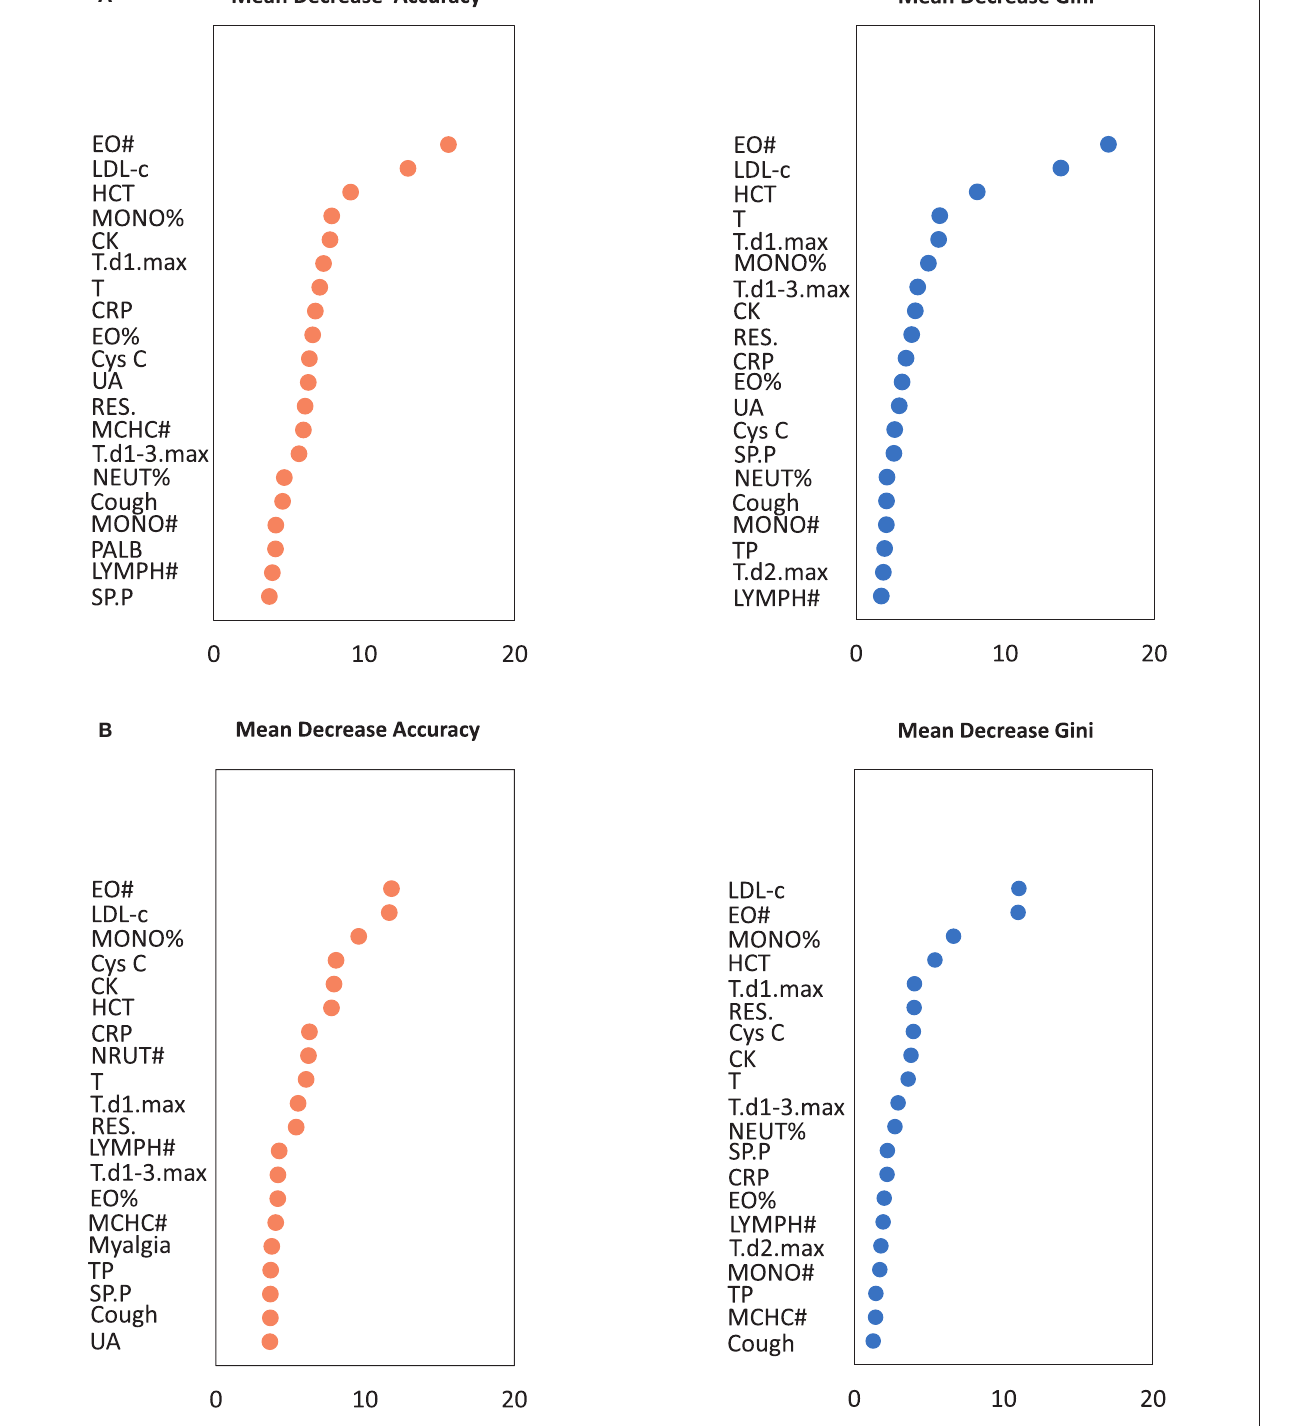
Frontiers in Medicine |